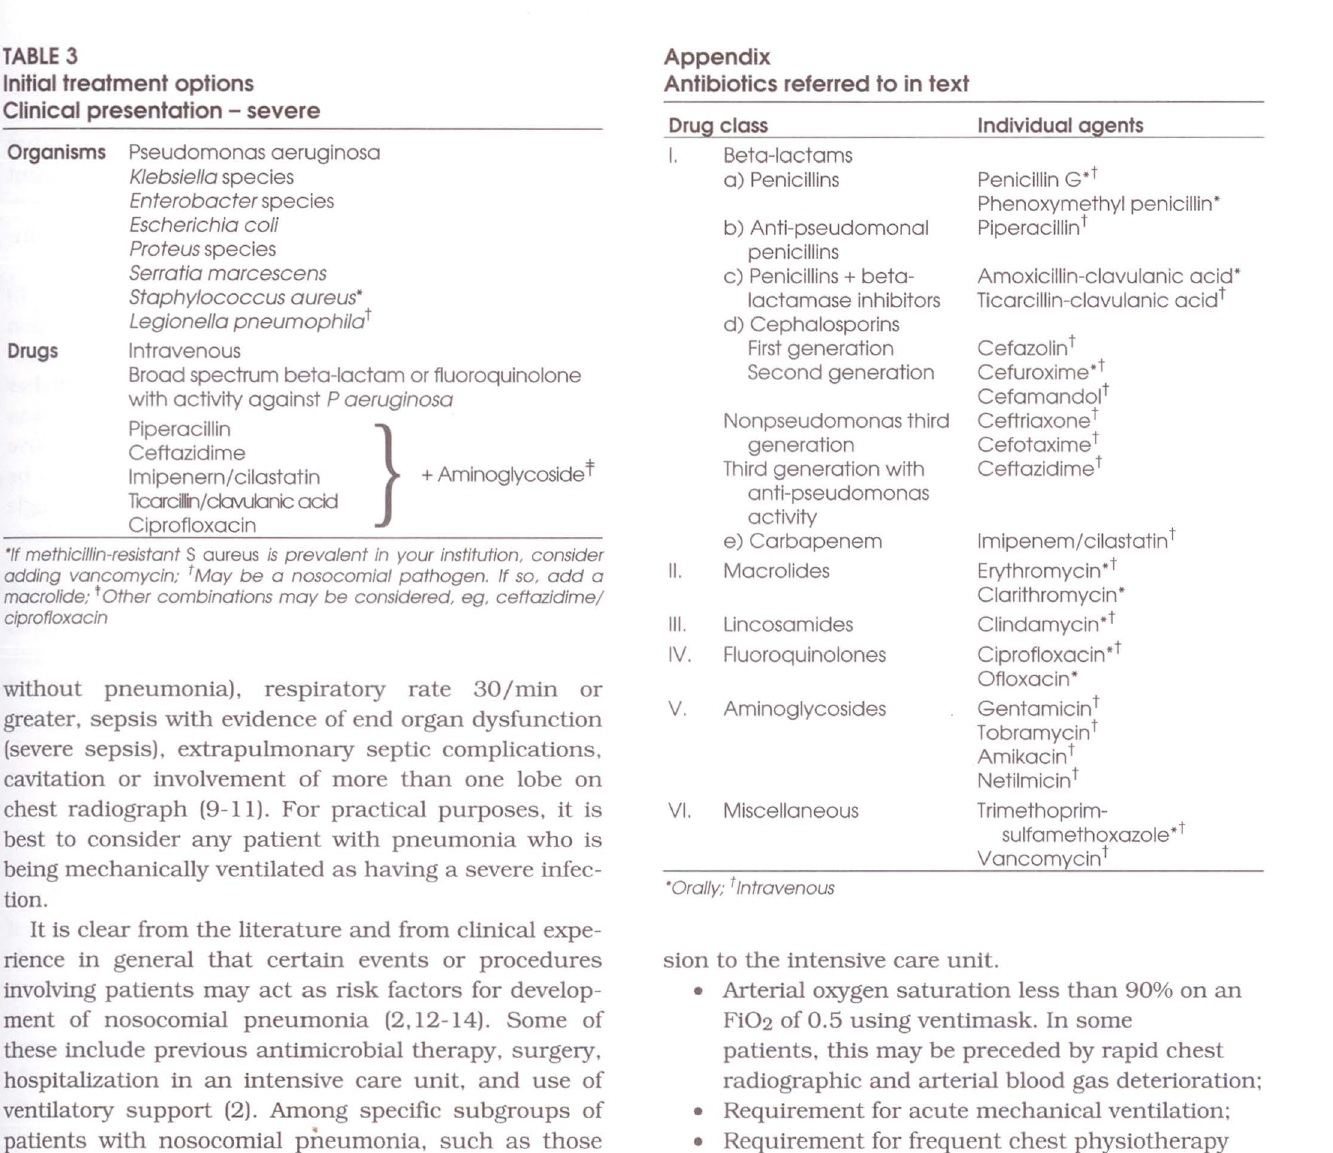
Initial treatment options Clinical presentation -